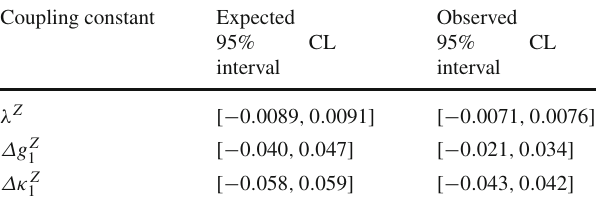
Table 6 One-dimensional limits on the ATGC effective Lagrangian (LEP parametrization) parameters at 95% CL from the combination of EW Wjj and EW Zjj